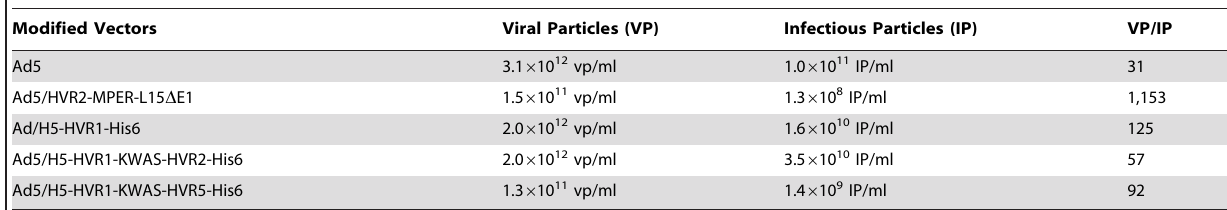
Table 2. Virological properties of